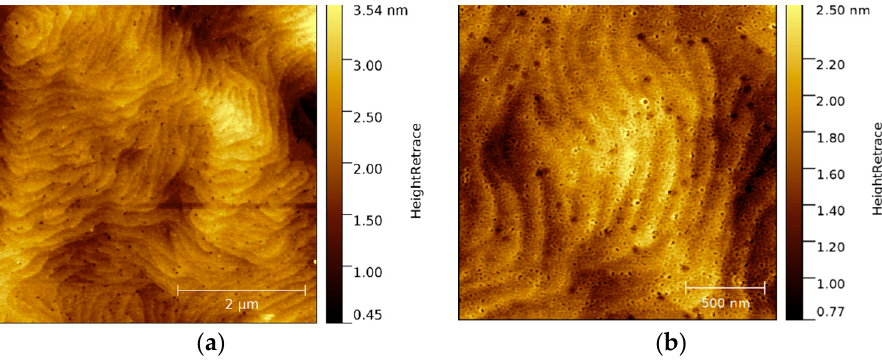
Figure 9. ( a ) A 5 × 5 µm² AFM image of the wet chemically cleaned p-GaN on silicon surface and ( b ) a higher magnification 1 × 1 nm² AFM image of the same sample ( b ) a higher magnification 1 × 1 nm 2 AFM image of the same sample.